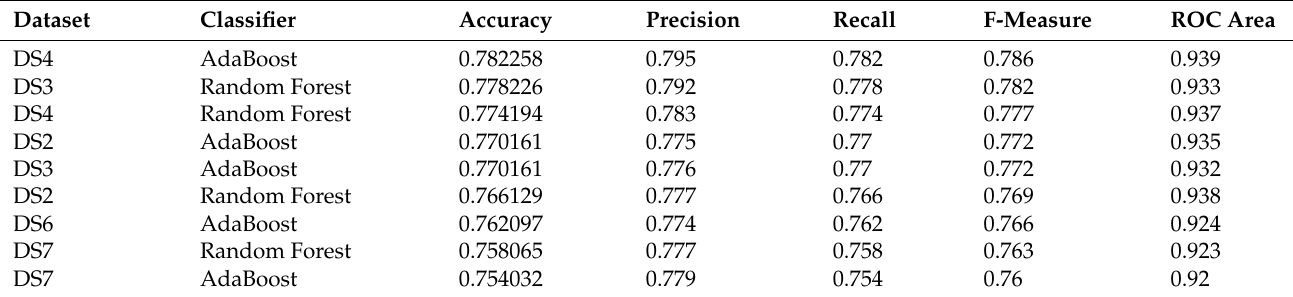
Table 10. Top-ten classifiers according to F-measure.